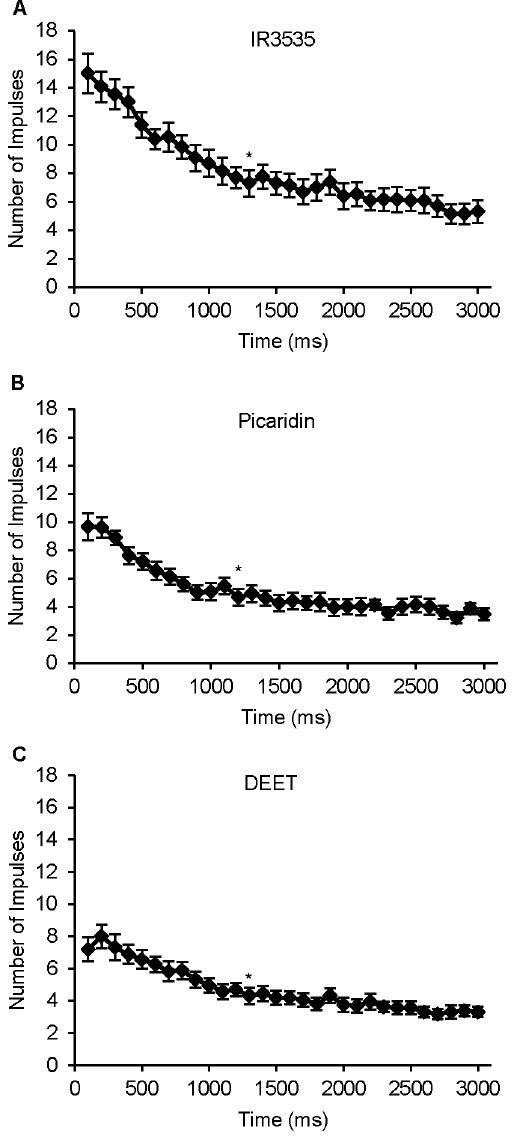
Figure 6. Temporal dynamics of the response of the deterrent- sensitive neuron to 10 mM concentrations of (A) IR3535, (B) picaridin, and (C) DEET. All repellents elicited a phasic-tonic firing pattern which peaked within the first 100–200 ms following stimulus onset and gradually decreased over the next 800 ms for picaridin and 1000 ms for both DEET and IR3535. A tonic rate of activity (marked by an asterisk) occurred after 1200 ms for picaridin and 1300 ms for DEET and